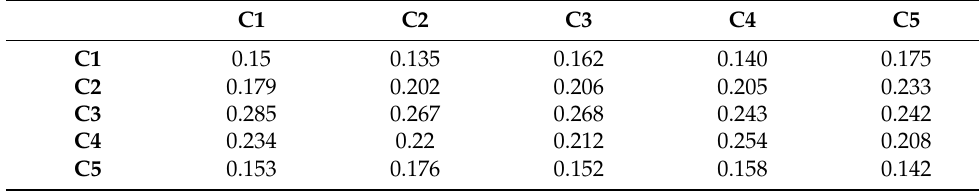
Table A8. Normalized Td matrix for dimensions.